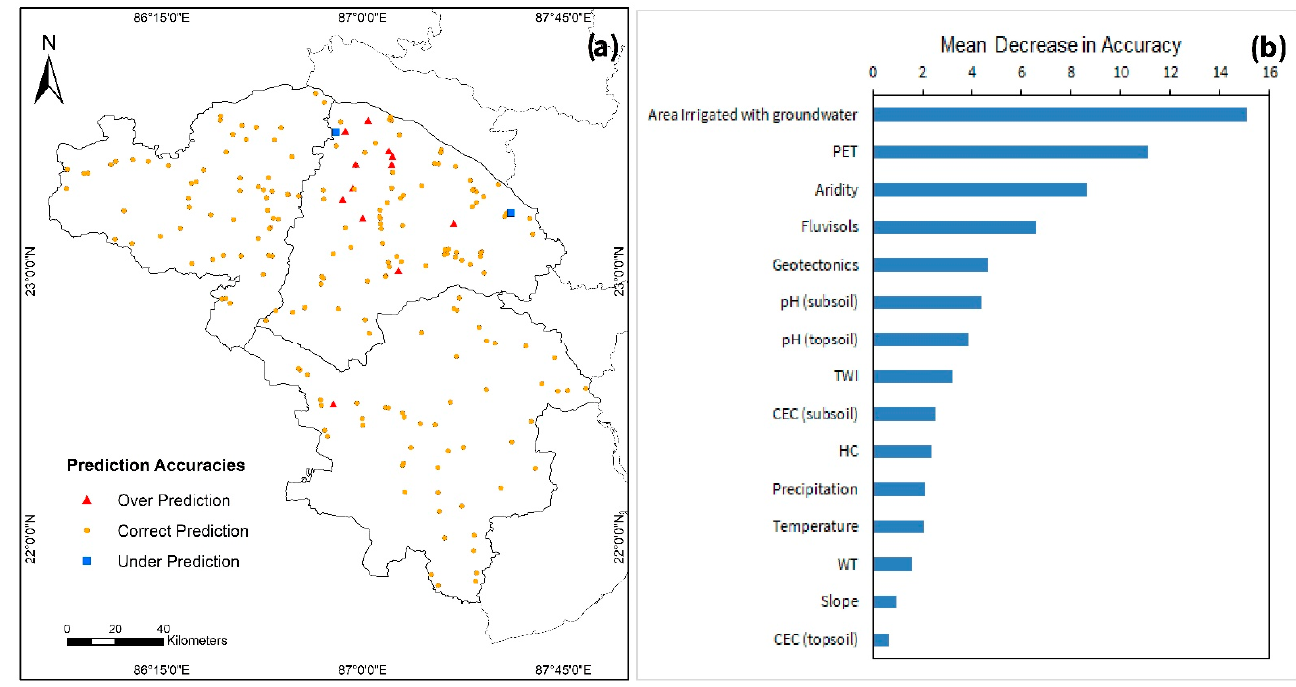
Figure 3. Predicted model maps, ( a ) probabilities of occurrence of groundwater F (>1.0 mg/L), ( b ) the population exposed to groundwater F above 1 mg/L.